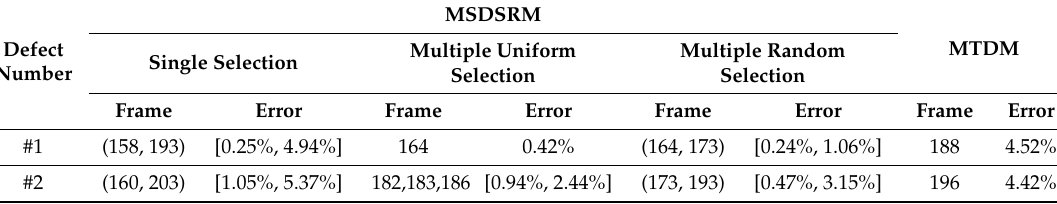
Table 5. Compared the results of MSDRM with those of maximum temperature difference method (MTDM) for PVC specimen.